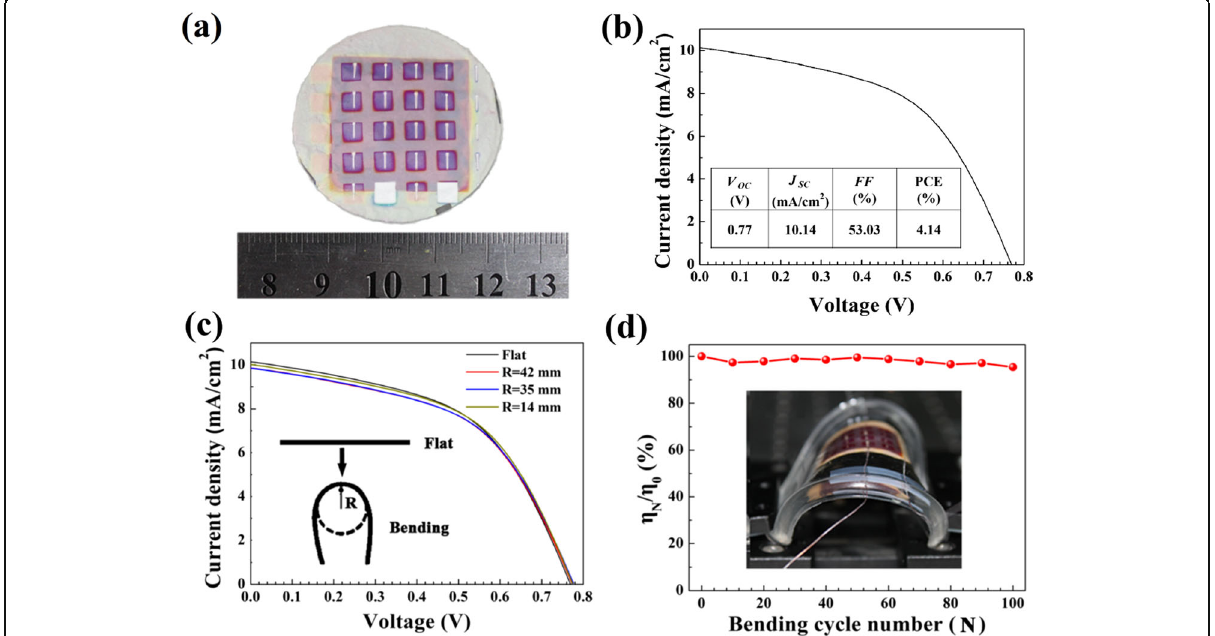
Fig. 7 a A photograph of the a -Si:H solar cells on the GP-3A. b A J-V curves of a -Si:H devices based on the GP-3A substrate after encapsulation. c J - V curves of a device on GP-3A substrate under different bending angles. d Relative efficiency as a function of bending cycles. The insets in c and d represent an illustration of defining bending angle and a bended device mounted on the measurement setup,